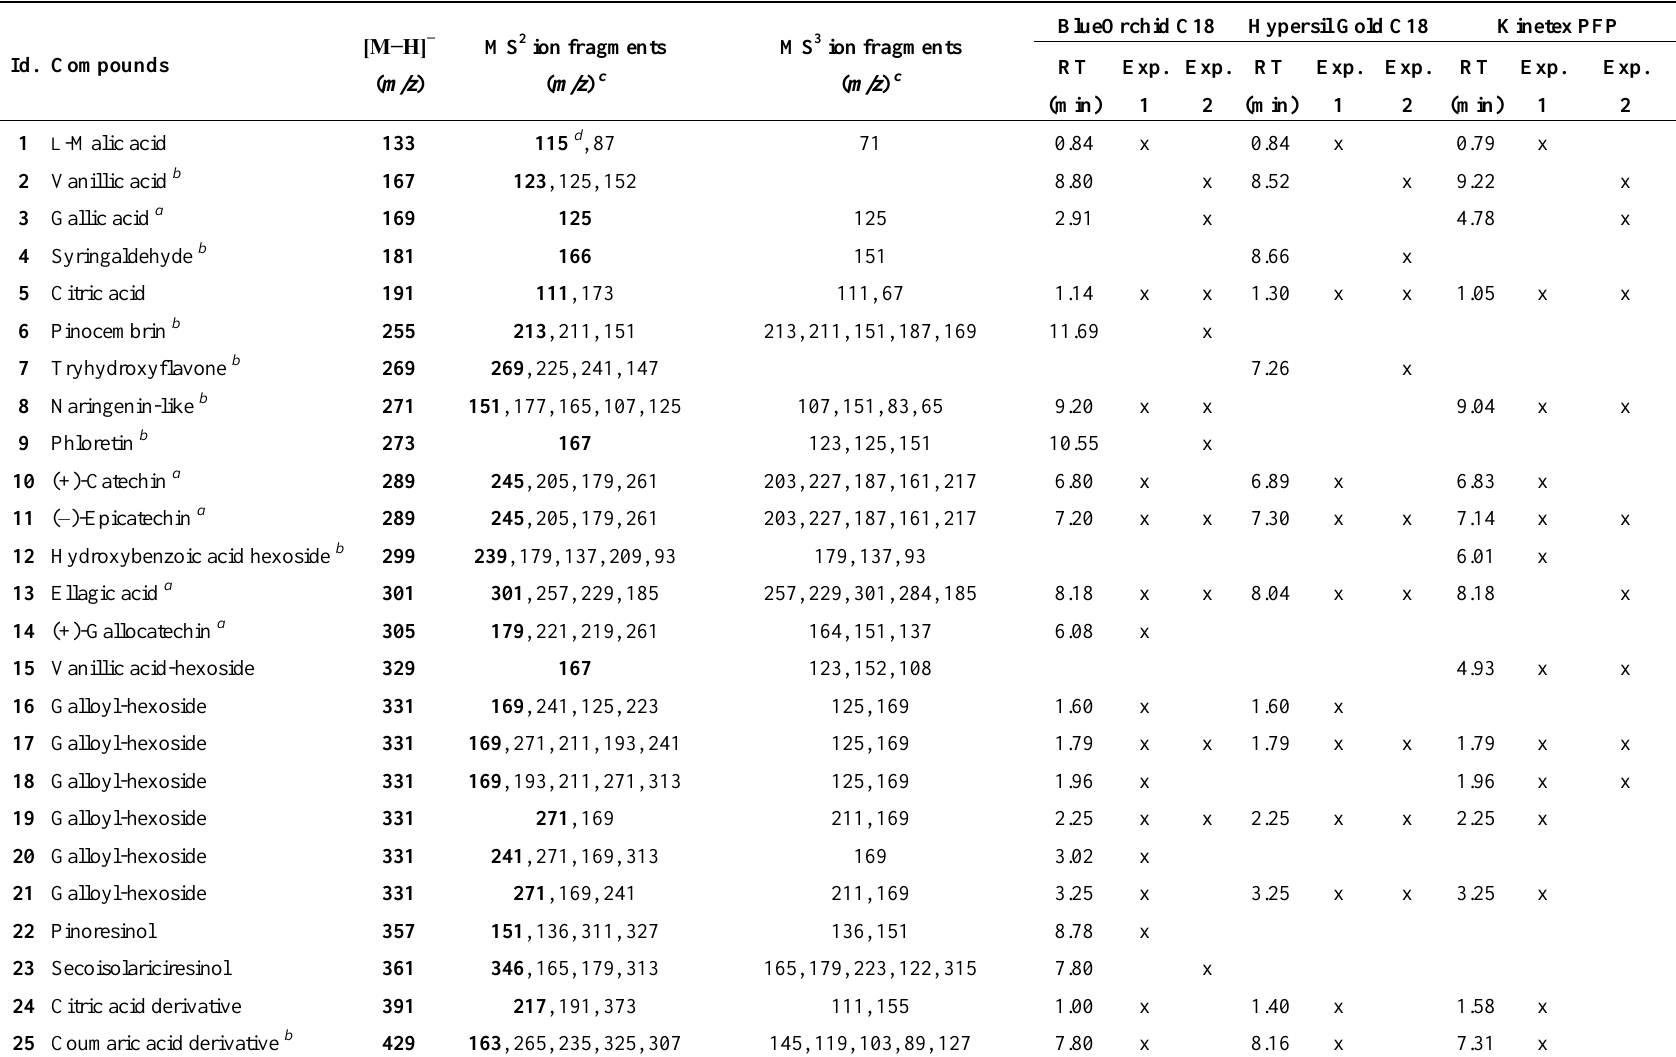
Table 1. Identification of phytochemical compounds by UHPLC-MS n in negative mode under different MS operating conditions and columns. Id.